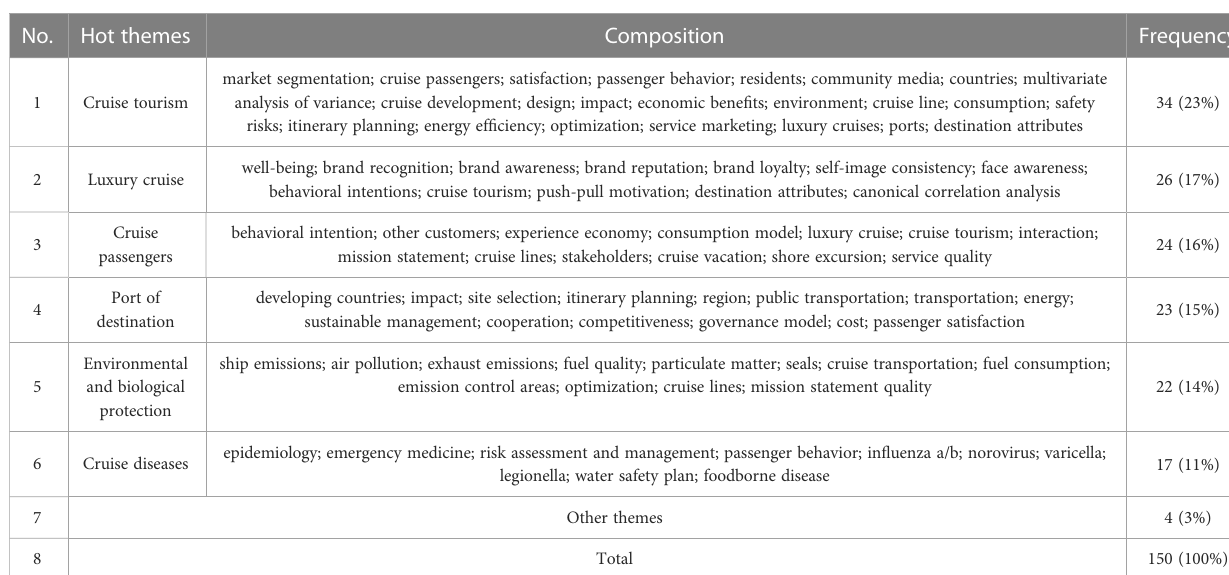
TABLE 4 Hot topics in cruise